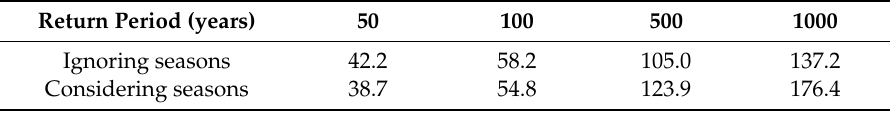
Table 13. E ff ect of statistical consideration of seasonality on maximum output flows MO (m 3 /